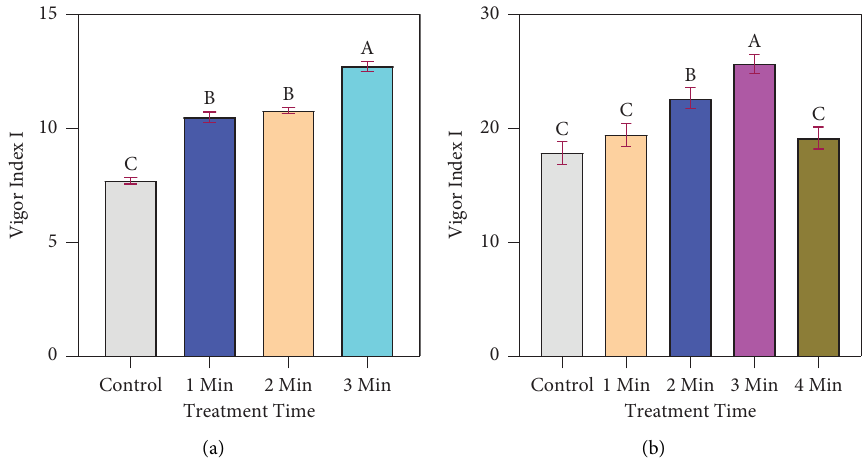
Figure 17: Infuence of CAPP exposure on the vigor index (I) of (a) radish and (b) carrot.